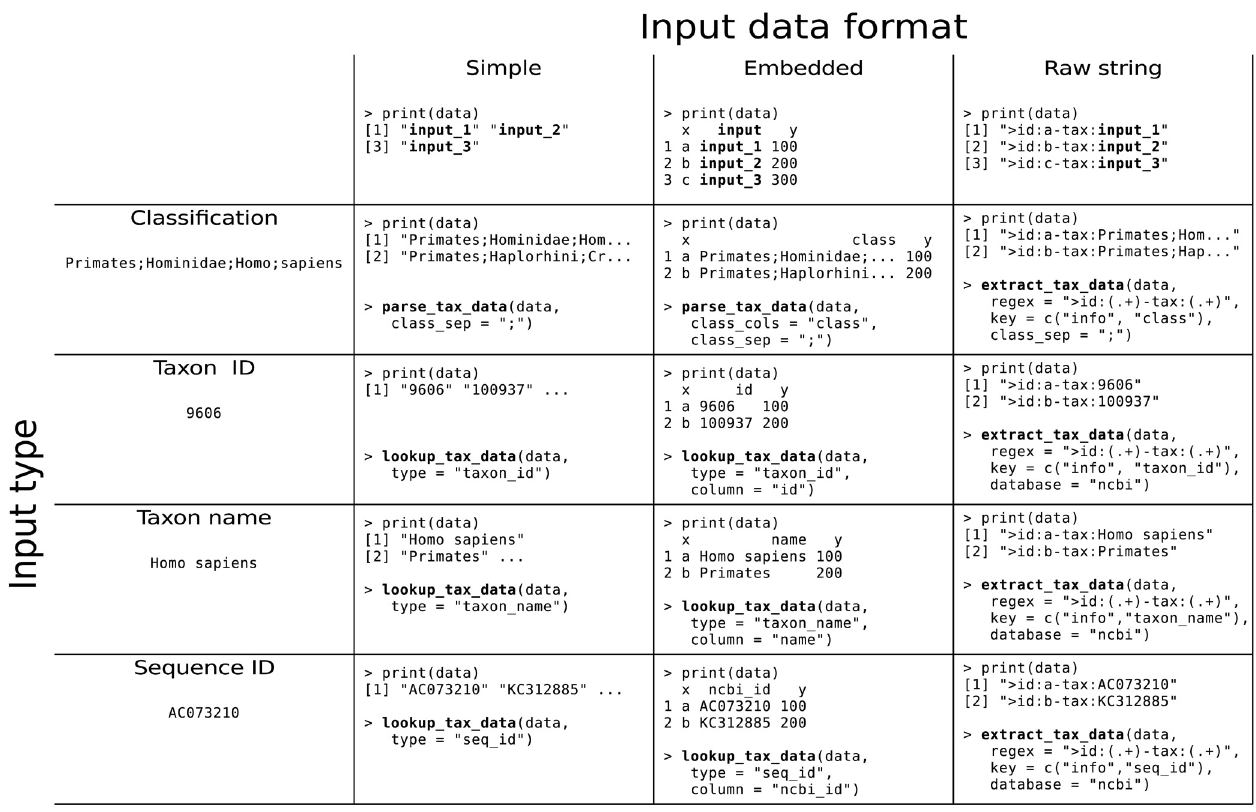
Figure 2. A table for determining how to parse different sources of taxonomic information using the taxa package. The rows correspond to the common sources of taxonomic information: full taxonomic classifications encoded in text, taxon IDs from a database, taxon names (a single rank), and NCBI sequence IDs. The columns correspond to the different formats the information can be encoded in: as a simple vector, as columns in a table, and as a piece of a complex string (e.g. a FASTA header). In the case of tables and complex strings, other information associated with the taxa can be preserved in the parsed result, as is done in the “use cases” example below. Any one cell in the table shows how to parse a given taxonomic information source in a given format using one of the three parsing functions: parse_tax_data, lookup_ tax_data, extract_tax_data